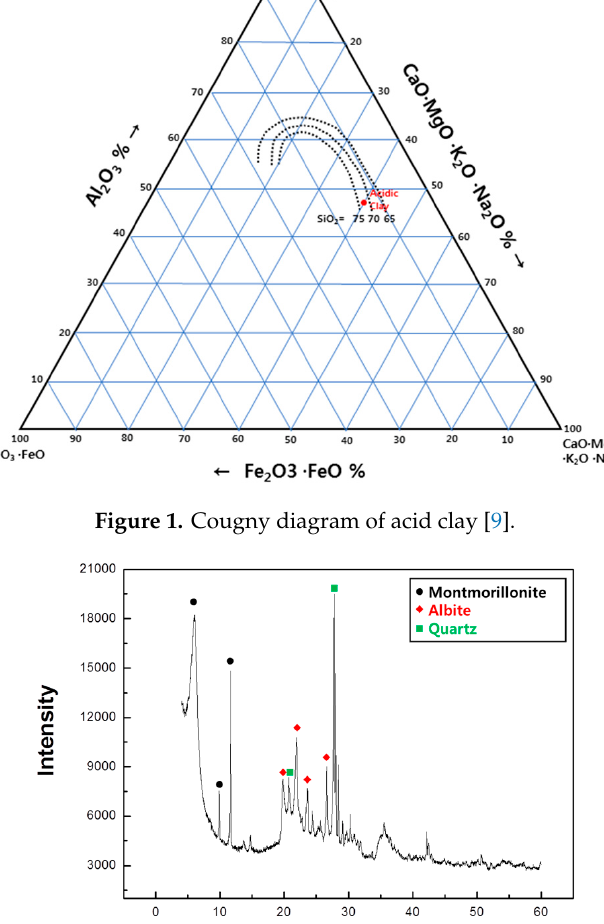
Figure 4. Particle size analysis results of raw acid clay . Table 3. Liquid limit (LL), plastic limit (PL) and plasticity index (PI) of acid clay. Liquid Limit (LL)